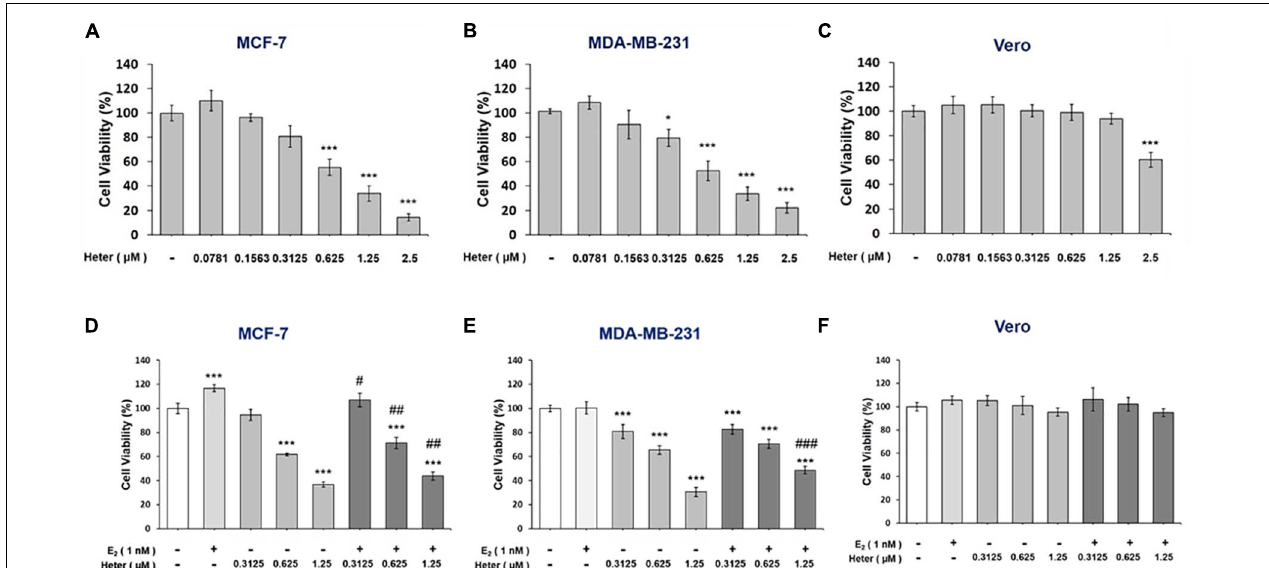
FIGURE 1 | Estrogen reverses heteronemin induces anti-proliferation in breast cancer cells. (A) MFC-7, (B) MDA-MB-231, and (C) Vero cells were treated with various concentrations of heteronemin with medium containing reagents refreshed daily for 72 h. (D) MCF-7, (E) MDA-MB-231, and (F) Vero cells were co-treated with various concentrations of heteronemin in the presence and absence of 1 nM E 2 for 72 h. Cell viability was detected with an Alamar Blue R (cid:13) Assay Kit. The number of independent studies ( n ) = 4. Results were expressed as the mean ± SD. * p < 0.05, *** p < 0.001 compared to the untreated control. # p < 0.05, ## p < 0.01, ### p < 0.001, compared to the same dosage of heteronemin treatment only. Heter: